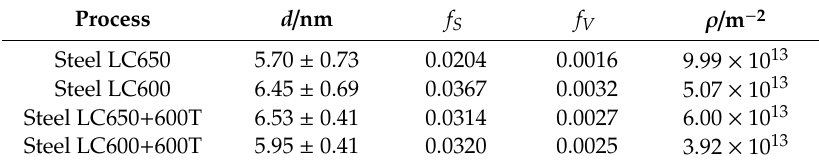
Table 3. The density of precipitates and dislocations at room temperature and elevated